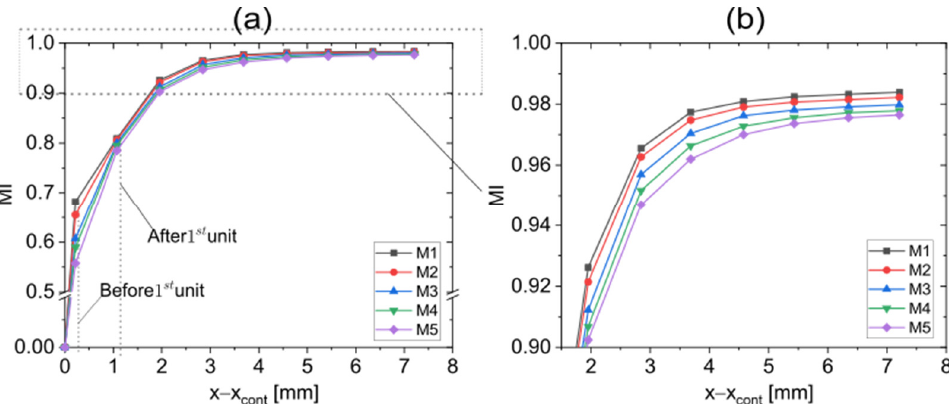
Figure 3. ( a ) Mesh convergence testing for a CLM having three stretch ‐ and ‐ fold units operated with a total flow rate of 36 μ L/min and a flow rate ratio of 10% to determine the required mesh level. MI values are plotted as function of the position in the microchannel for different mesh levels. ( b ) Zoom in of an MI range between 0.9 and 1. Table 2. Influence of meshing on Pe (cid:2913)(cid:2915)(cid:2922)(cid:2922) , (cid:2911)(cid:2932)(cid:2915) and Pe (cid:2913)(cid:2915)(cid:2922)(cid:2922) , (cid:2923)(cid:2911)(cid:2934) .